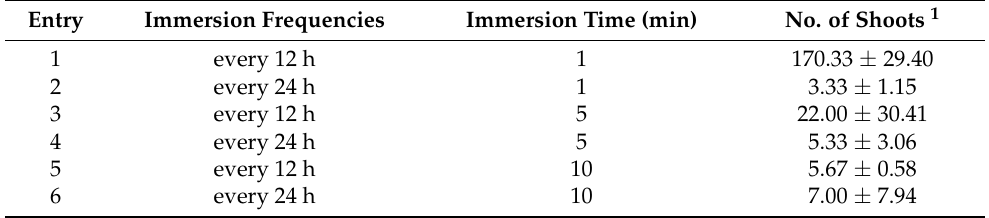
Table 2. Effects of immersion time and frequency on the number of shoots per explant of R. officinalis .